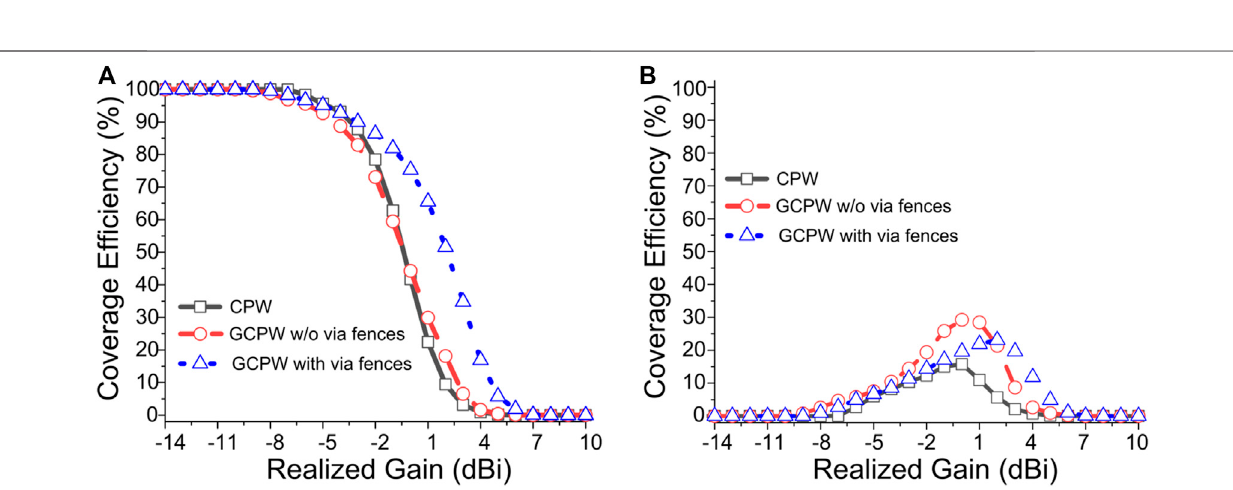
Frontiers in Communications and Networks |